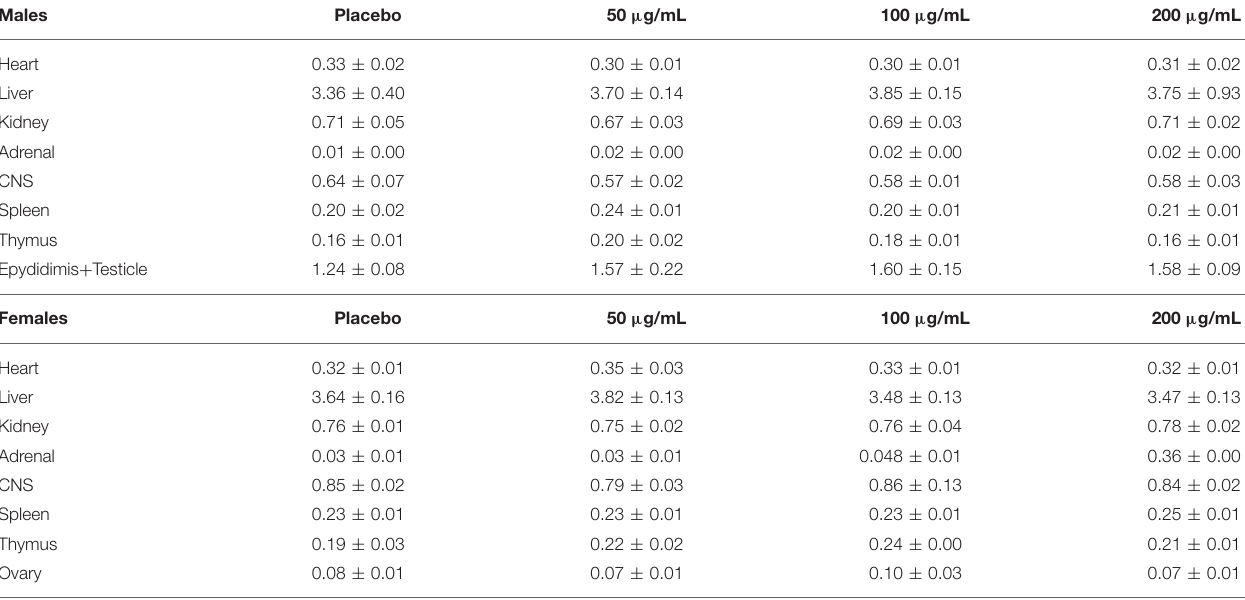
TABLE 3 | Relative organ weights from the male and female Wistar rats after administration of StreptInCor at 50, 100, 200 µ g/mL doses or placebo. Males